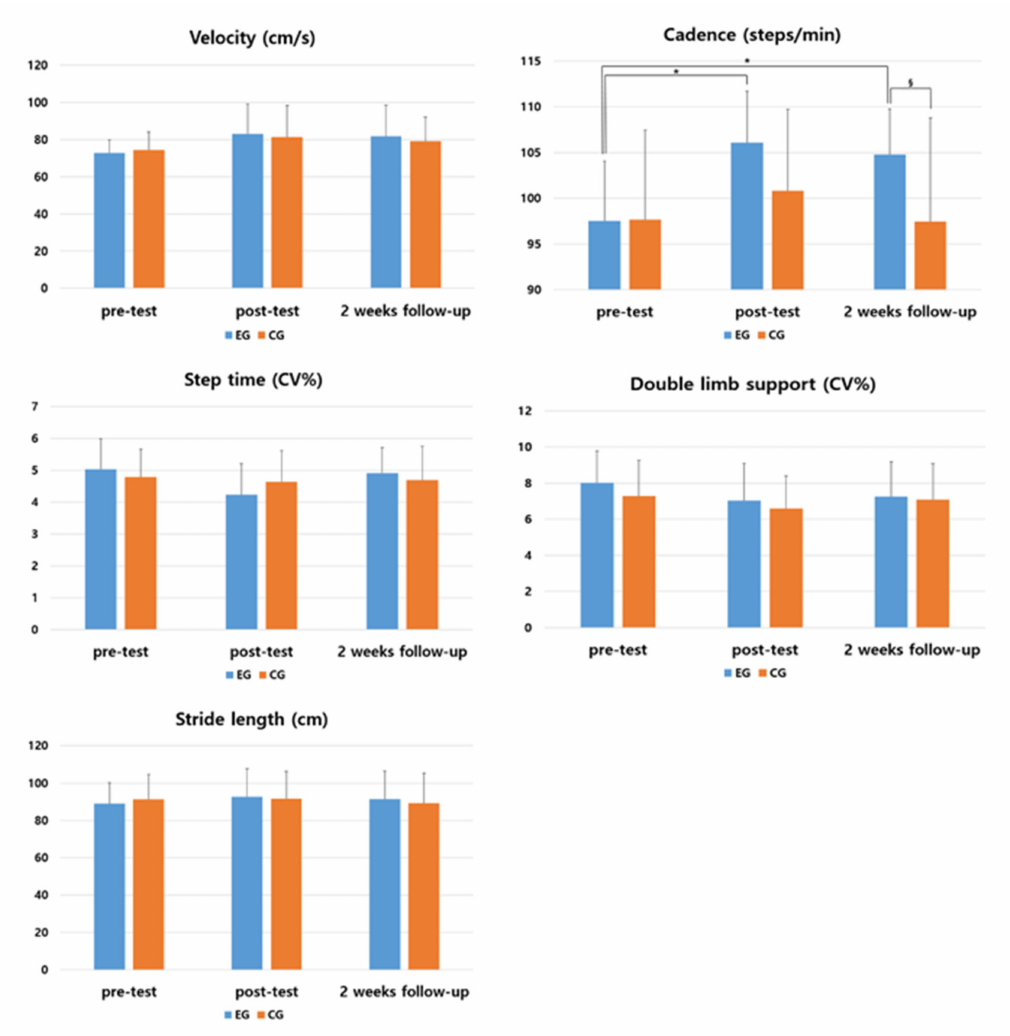
Figure 5. Comparison of the changes of within and between groups in gait variables. * means a statistical significance within the group as compared to pre ( p < 0.05). § means a statistical significance by measurement period between groups ( p <